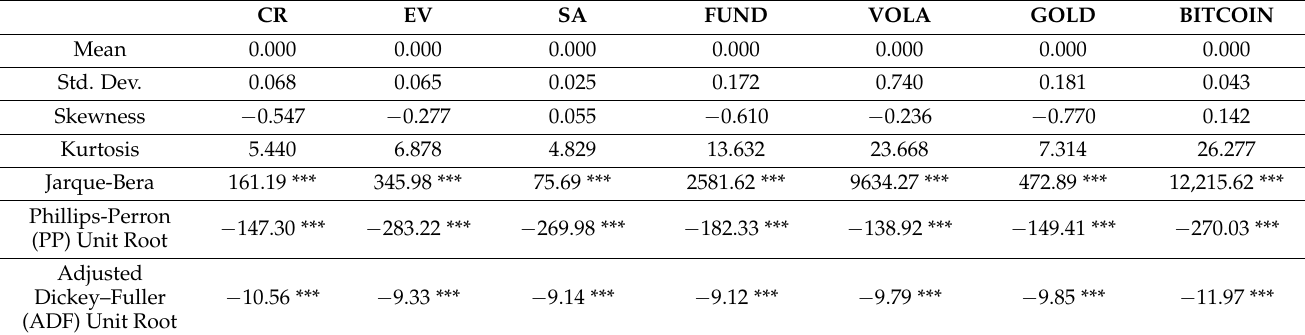
Table 1. Descriptive Statistics and Unit-Roots Test